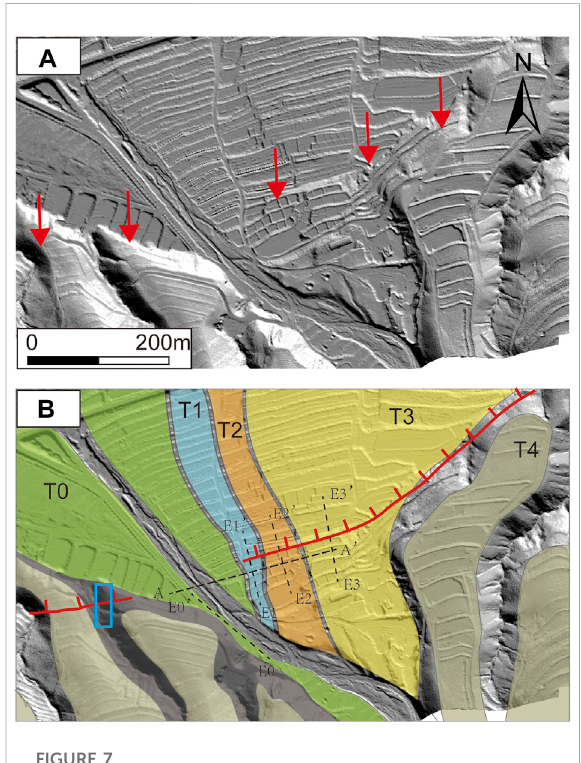
FIGURE 7 Tectonic landforms near the Luofengwa trenching site. (A) s-UAV DEM imagery of the Luofengwa alluvial fan, red arrows represent the trace of the Liulengshan Fault; (B) interpreted map. The red line indicates the trace of the LLSF; T0 – T4, alluvial phases; A – A ′ , E1 – E1 ′ , E2 – E2 ′ , and E3 – E3 ′ are topographic pro fi les; the blue box in Figure 7B indicates the position of the trench. The color version of the fi gure is available only in the electronic